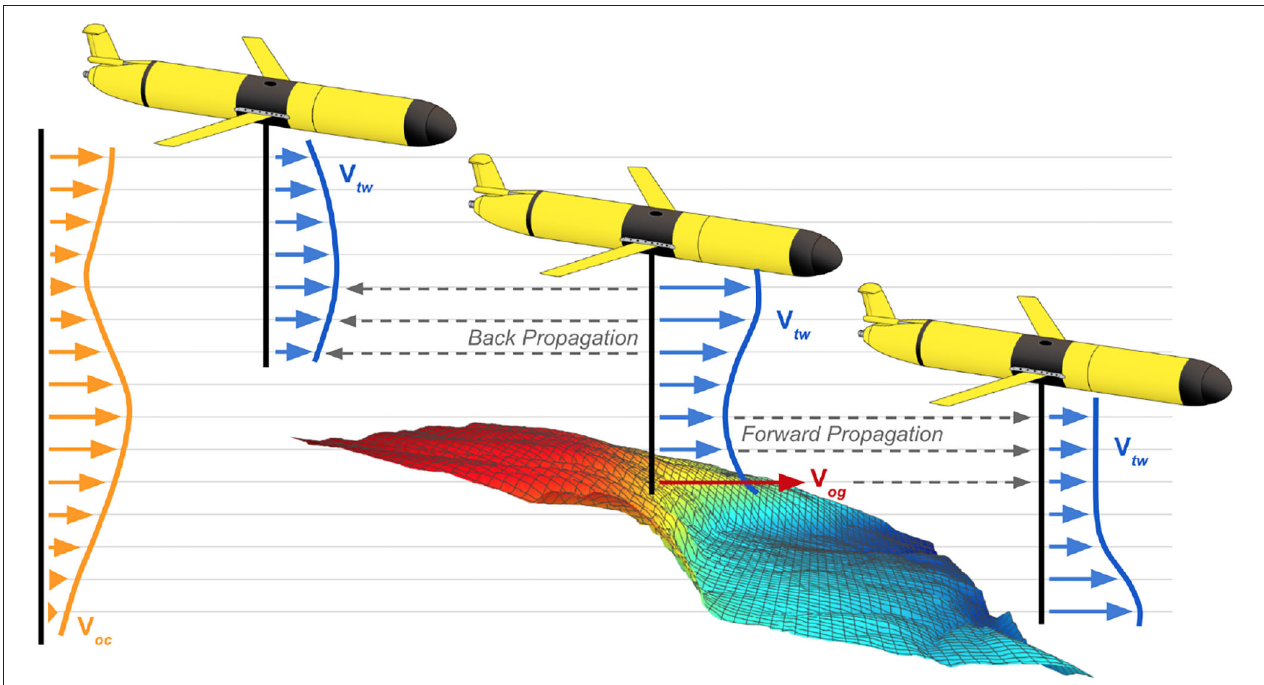
FIGURE 7 | Schematic diagram of the velocity shear propagation (VSP) method being used to estimate water column currents. The VSP method uses forward propagation and back propagation to estimate ocean currents throughout the water